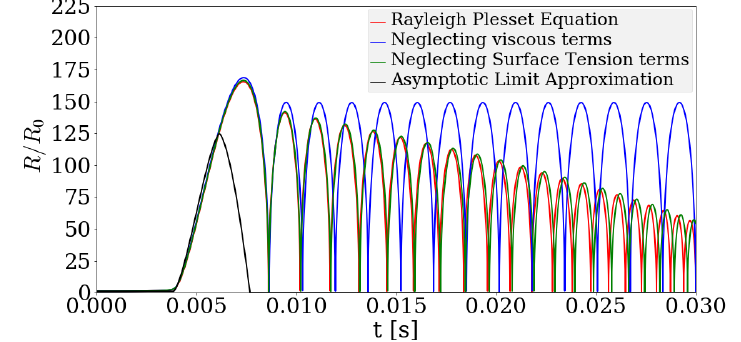
Figure 5. Variation of the non-dimensionalized radius of a spherical bubble with initial radius R 0 = 50 µ m with parameters: ν l = 1.3 × 10 − 6 m 2 /s, ρ l = 1000 kg/m 3 , p v = − 0.7 bar gage pressure, σ = 72.75 × 10 − 3 kg/s 2 and ˙ R 0 = 0 m/s, subjected to forced pressure variation shown in Figure